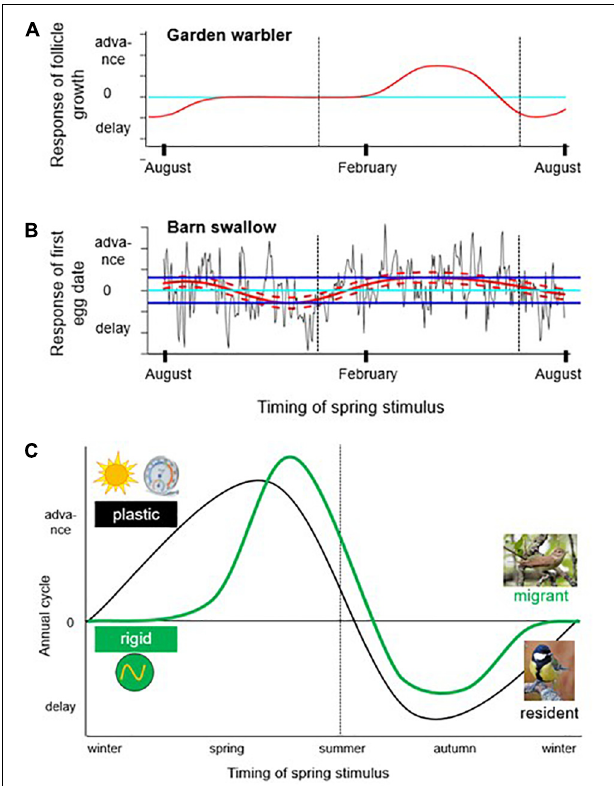
FIGURE 3 | Responses to environmental factors depend on the phase of the annual cycle. Graphs show advance and delay responses of seasonal events ( y -axis) to cues experienced at different times of year ( x -axis). (A) Alternating responses to temperature and precipitation, depending on the phase of the annual cycle, has been described as the dominant pattern of wild organisms based on 10,000 time series from the UK (Thackeray et al., 2016). Shown is the phase-dependent temperature response of egglaying in wild Barn Swallows (image kindly generated by Dario Massimino). (B) Phase-dependent response of follicle growth to photoperiod in captive Garden Warblers (based on Gwinner, 1996a). (C) Schematic difference between migrants and residents in the phase-specific response to spring-like cues. In late winter and spring, long days and high temperatures advance subsequent life cycle stages, such as spring migration and reproductive activation. Conversely, later in the year the response reverses, and long days and high temperatures delay life-cycle stages. Long-distance migrants (inlay: Garden Warbler) differ from residents (inlay: Great Tit) by a rigid phase during wintering, when long days and high temperatures have little or no effect on the annual cycle; image credit to commons.wikimedia.org: Garden Warbler by Kristjan Osbek, Great Tit by